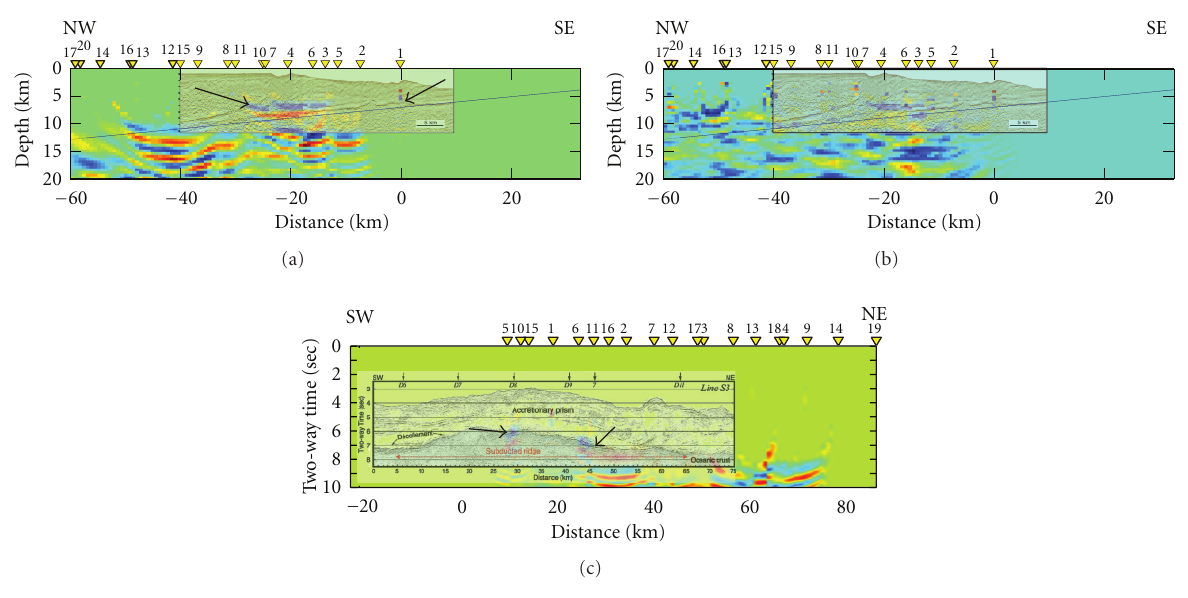
Figure 13: PSDM-imaging results. (a) Stacked profile projected to Line KR9806 (Figure 9(a)) running perpendicular to the trough axis. The seismic profile from Moore et al. [9] is overwrapped in this profile. Arrows show the imaged oceanic crust surface. (b) Stacked profile projected to Line KR9806 using all crosscorrelation traces. (c) Stacked profile projected to Line S3 (Figure 9(a)) running parallel to the trough axis. The seismic profile from Park et al. [10] is